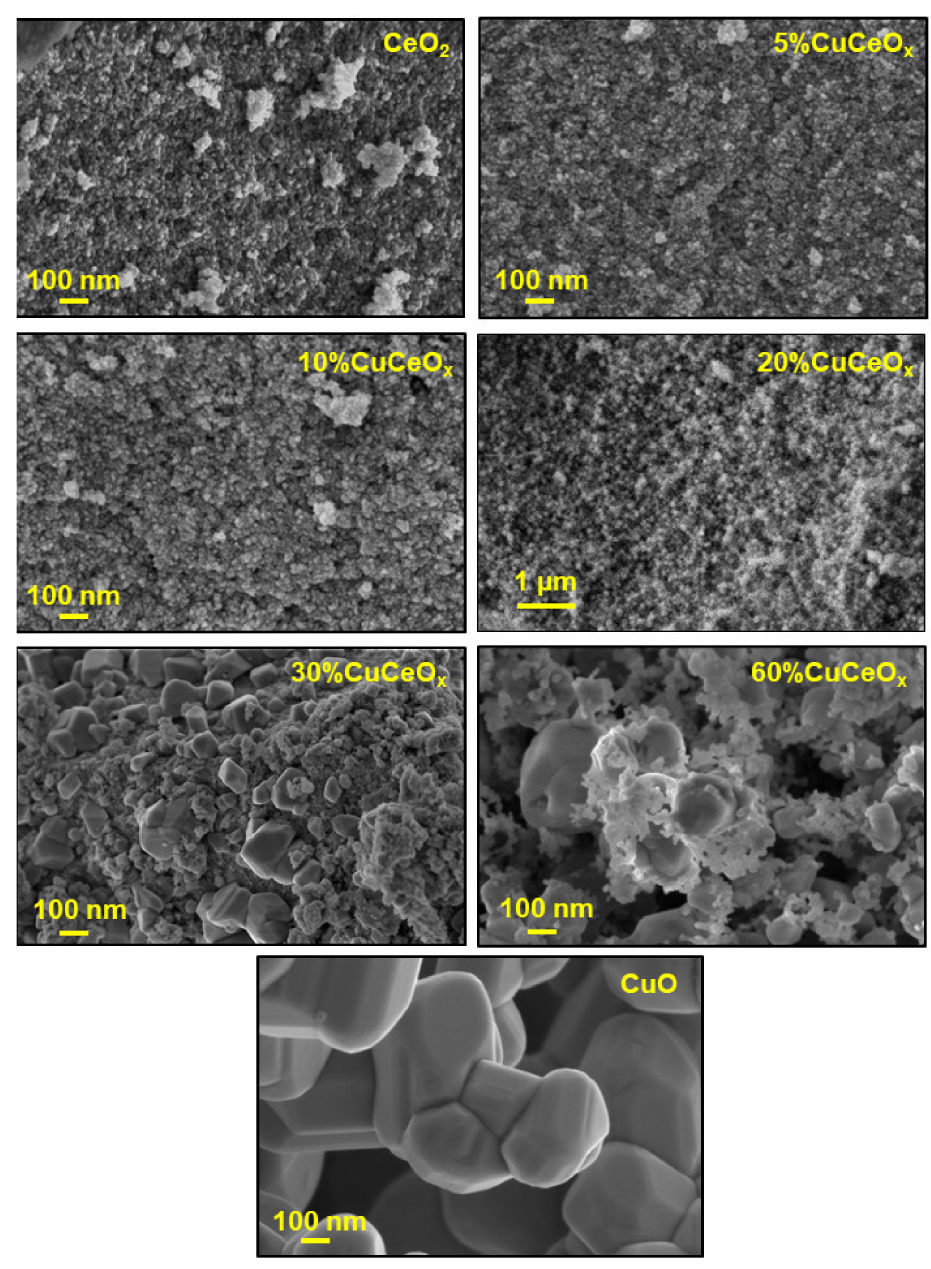
Figure 2. FESEM images of the CuCeO x